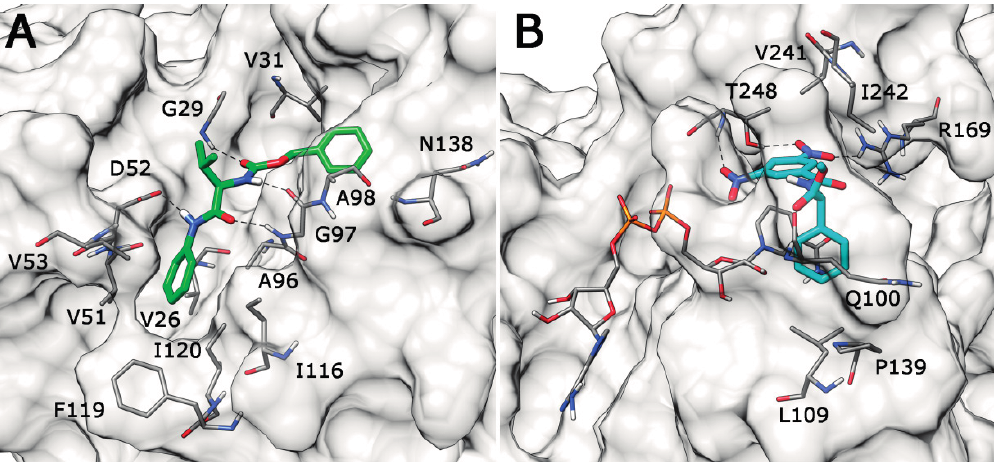
Figure 5. Minimized average structures of Compounds VS6 ( A ) and VS8 ( B ) docked into h LDH5.